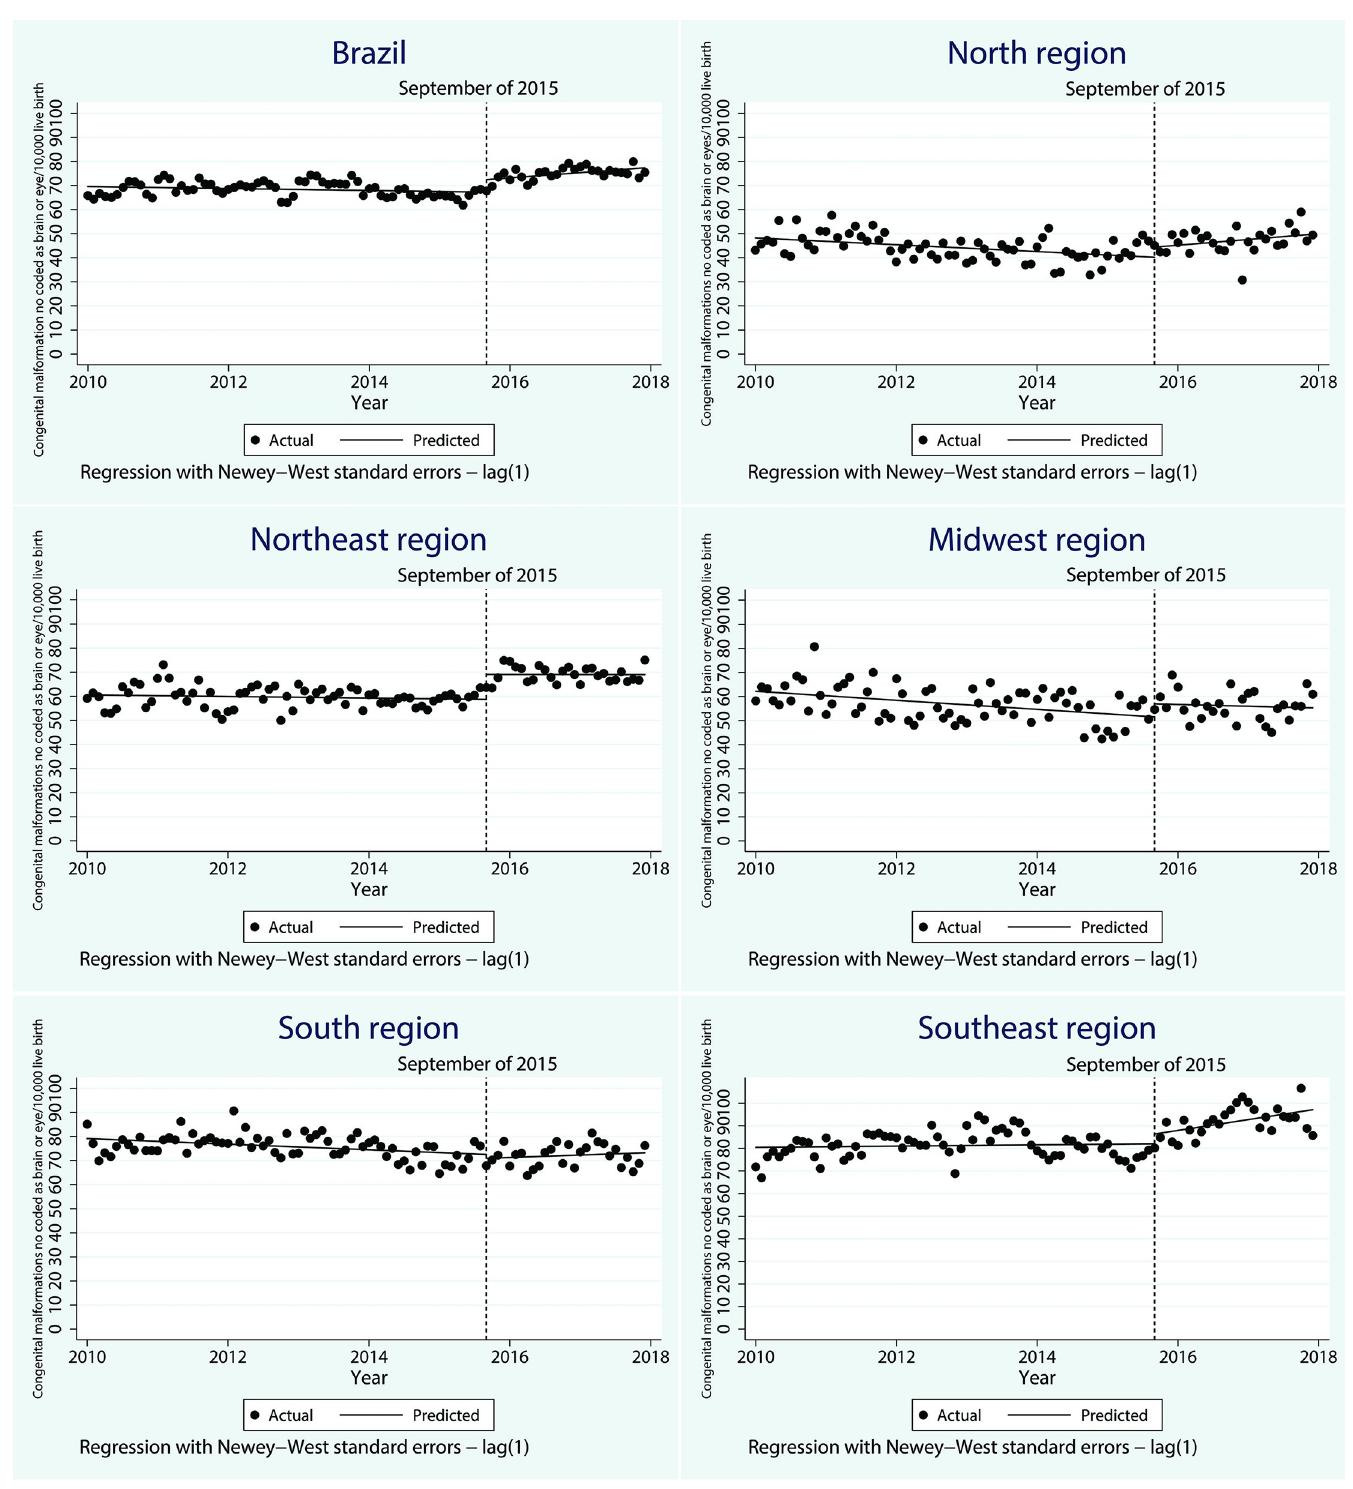
Fig 2. Time series of non-brain or eye congenital anomalies in Brazil and regions from 2010–2017.